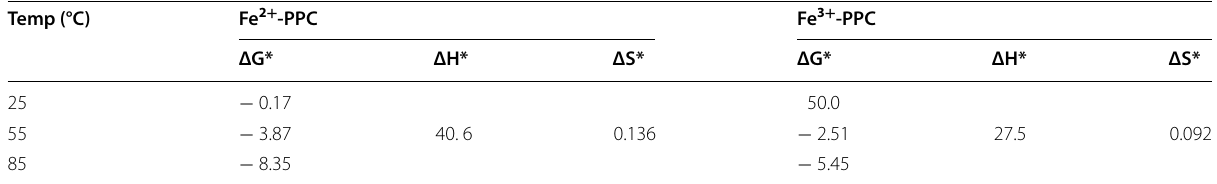
Table 4 Thermodynamic parameters for Pb(II) adsorption on iron modified pomegranate peel carbons (Fe 2 + -PPC and Fe 3 +